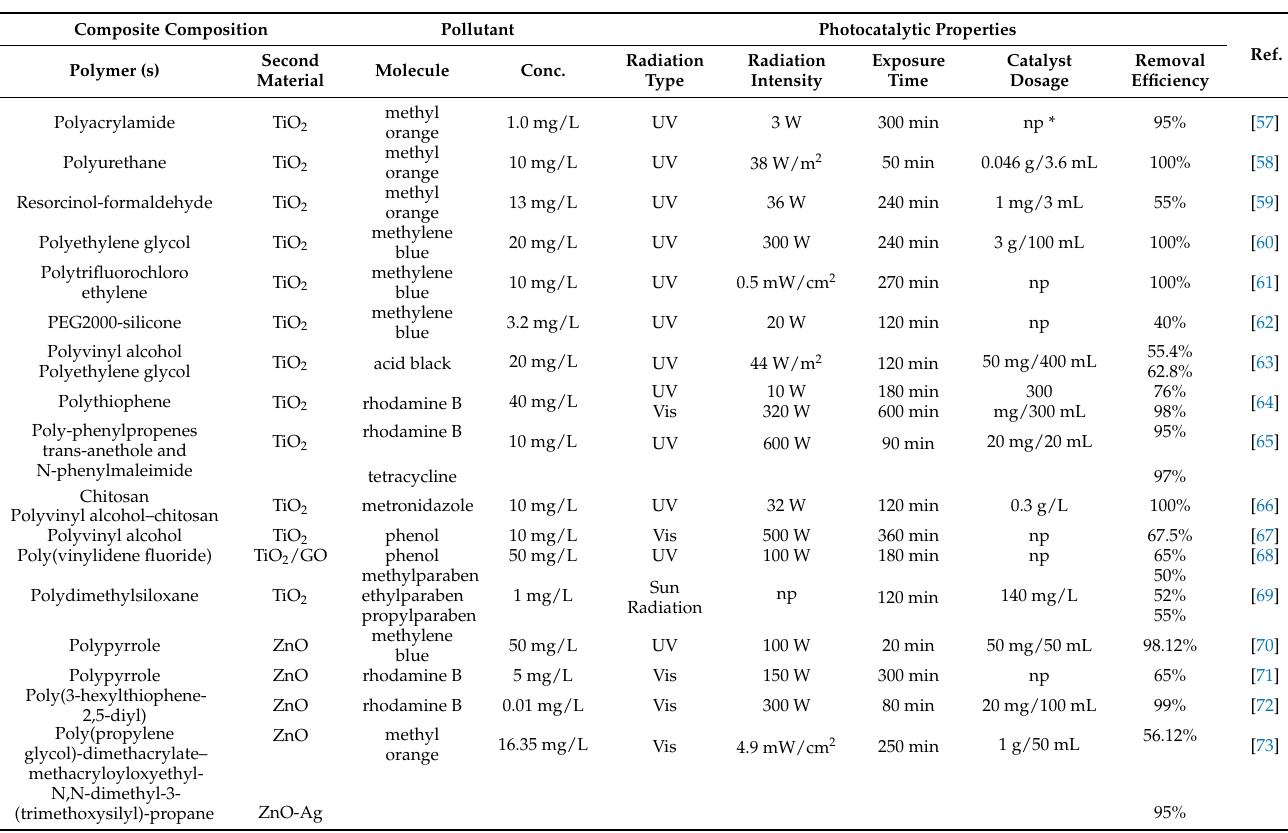
Table 1. Polymer/TiO 2 - or ZnO-based